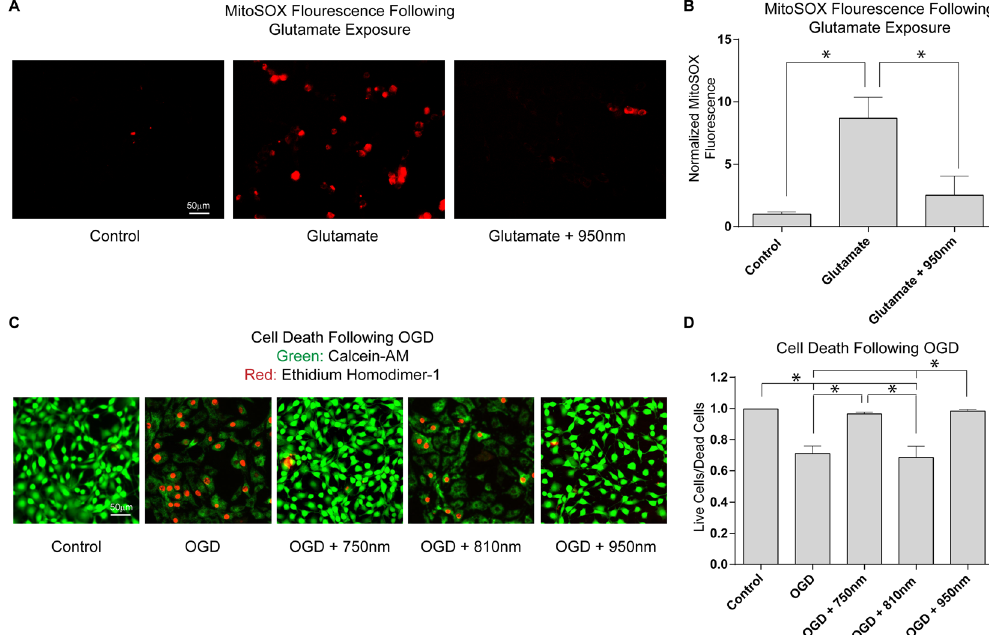
Figure 3. Effect of NIR on cultured HT22 cells following glutamate exposure and OGD. ( A and B ) Glutamate induced oxytosis in HT22 cells labeled with MitoSOX (n = 4 per group, * p < 0.05). ( C and D ) % Viability of control cells (green live/red dead), cells subjected to simulated I/R (1 h OGD + 24 h reoxygenation), and cells exposed to I/R treated with excitatory NIR (810 nm) and each inhibitory NIR wavelength (750 or 950 nm, n = 6 per group; * p <